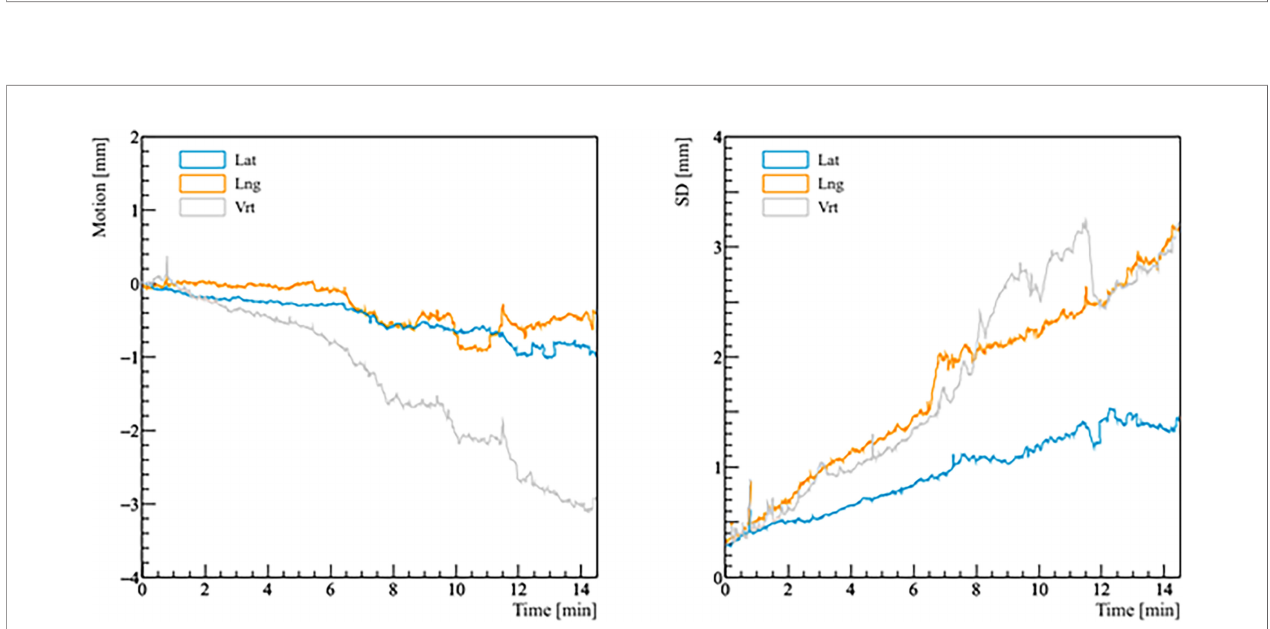
FIGURE 2 | Distribution of the real prostate translational motion with no interruptions and patient position corrections. The positive axis represents a displacement in left, superior, and anterior directions, respectively.